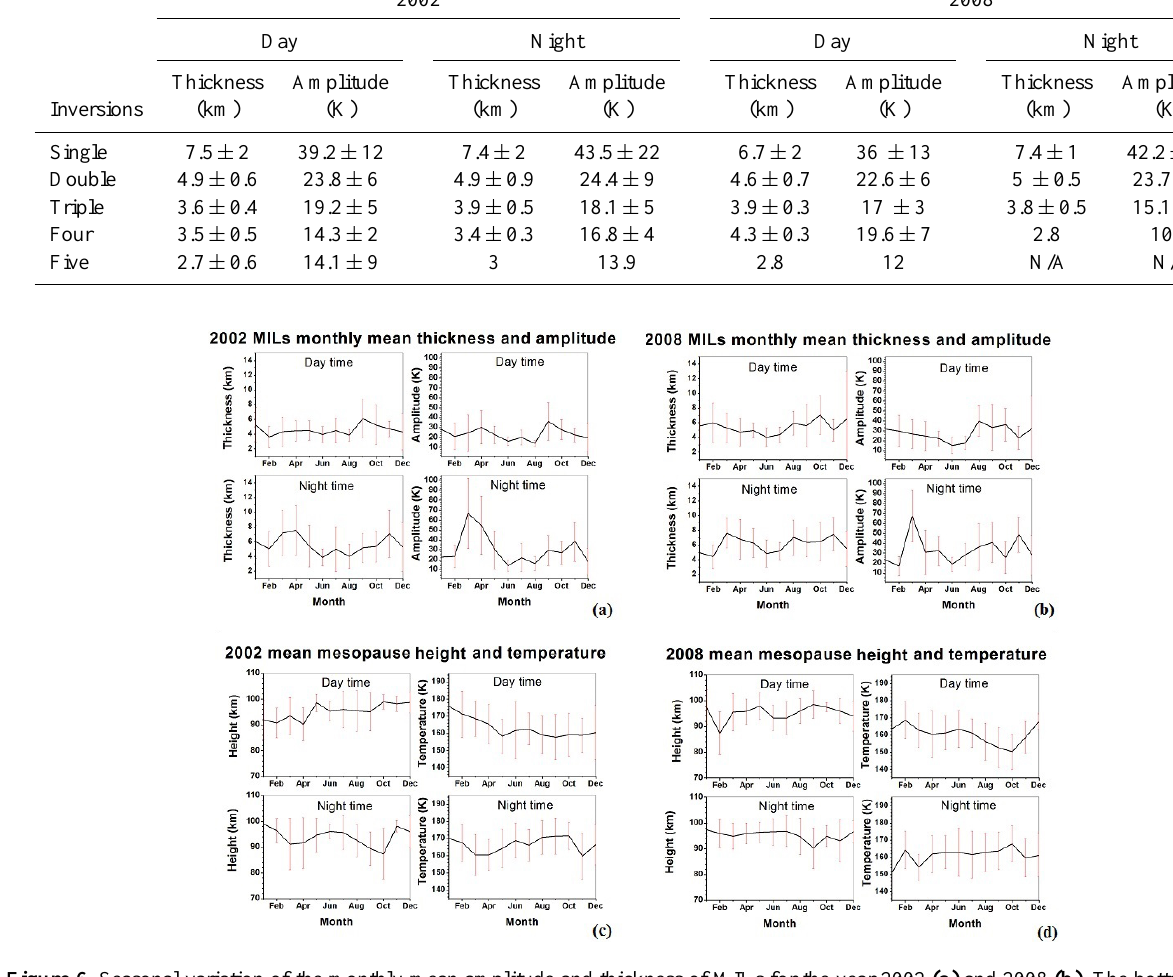
Figure 6. Seasonal variation of the monthly mean amplitude and thickness of MILs for the year 2002 (a) and 2008 (b) . The bottom panels plot the variations of monthly mean mesopause height and temperature for 2002 (c) and 2008 (d) . The error bars show the standard deviation in the monthly average